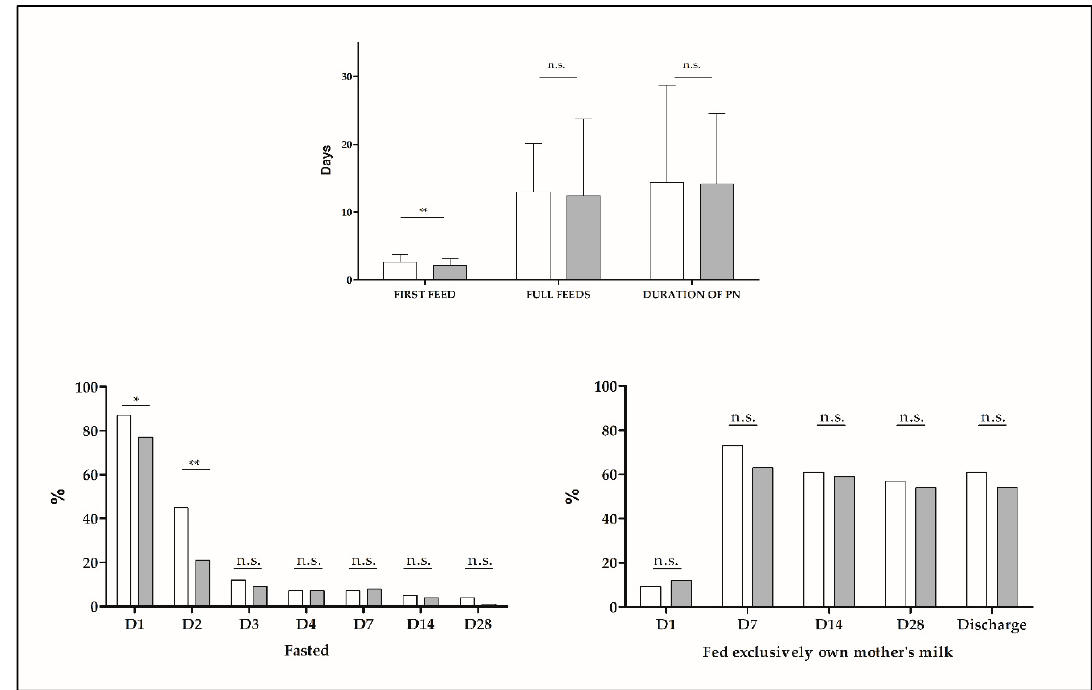
Figure 2. Summary of nutritional characteristics of very preterm infants (VPI) in G1 (white) and G2 (grey). * p < 0.05; ** p < 0.001; n.s.: non-significant ( p -value > 0.05). G1: Group 1, G2: Group 2, D: Day of life, PN: Parenteral nutrition.